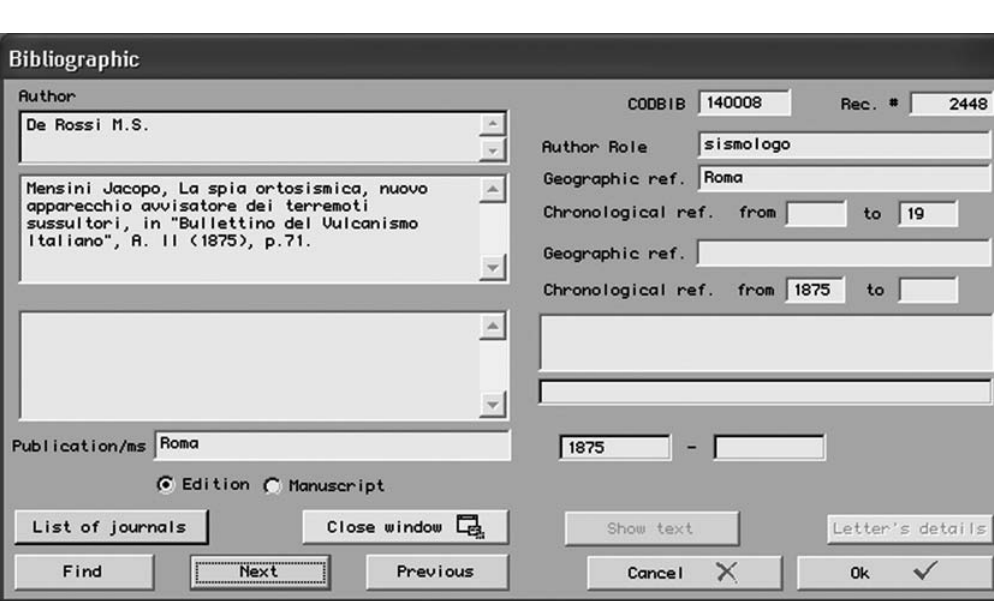
Fig. 9. Bibliographic file, main search window. In this file different kind of printed and manuscript documents (observatories, instruments, scholars, earthquakes etc.) are stored: selected papers from scientific journals, books, station bulletins, station handbooks, letters etc. Each chart reports the bibliographic code (CODBIB) and the progressive order of the document and, if available at the current state of the research, the following information: name, role, geographical and chronological refer- ence of the author; title, geographic and chronological reference of the document; the place and date of the pub- lication; whether it is a publication, a manuscript or a copy of a manuscript. In the case of scientific correspondence, if further information is available for a letter, a button named «Letter Details» is activated, which, once pressed, opens the window with the details of the related letter, and the chance to open the PDF file of the integral raster reproduction of the